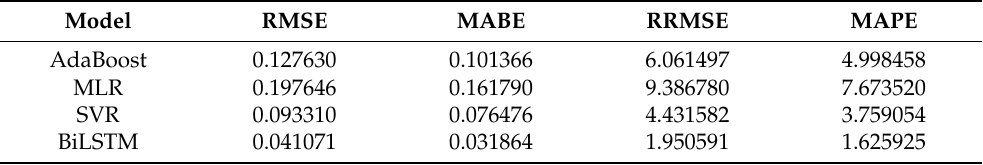
Table 8. Model error metrics for Tuvalu.